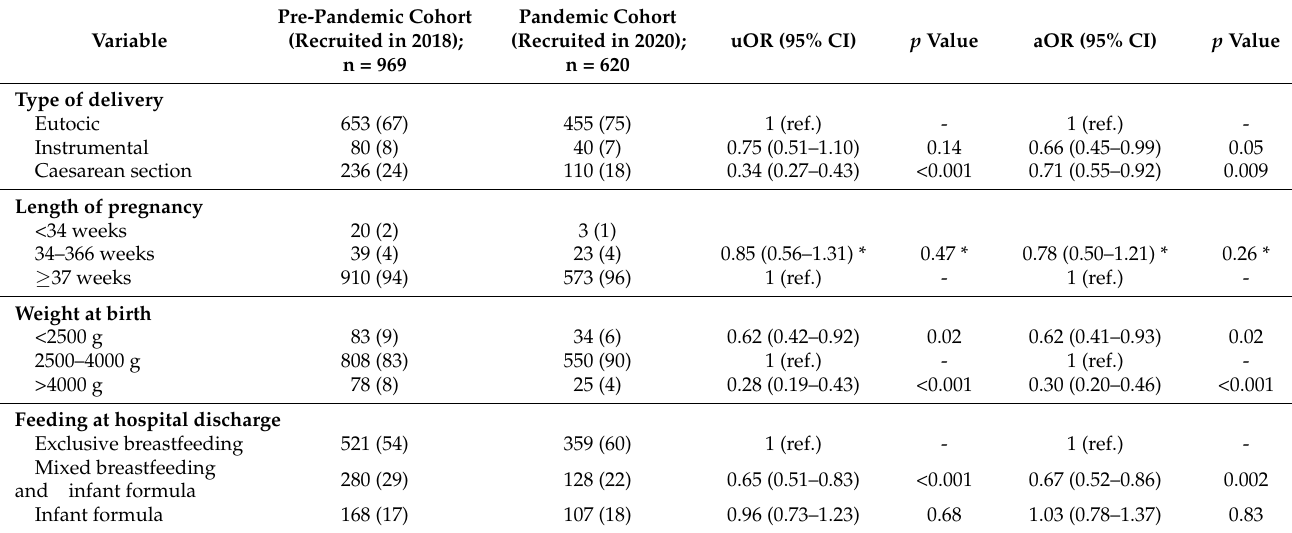
Table 2. Type of delivery, length of pregnancy, and weight at birth in the two cohorts. In the pandemic cohort, only sub-cohorts 1 and 2 are included, as most pregnancies in sub-cohort 3 are still ongoing. Pre-Pandemic Cohort Variable (Recruited in